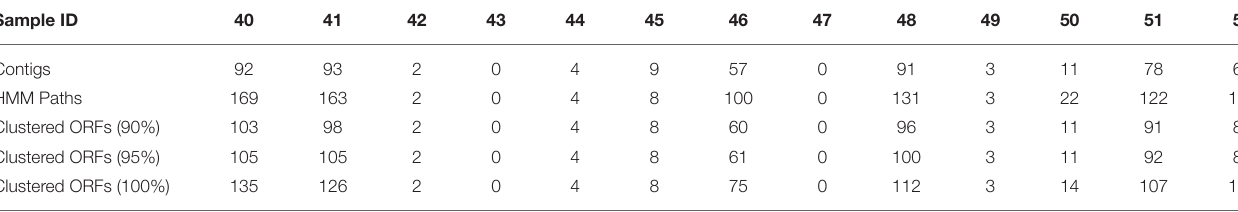
TABLE 1 | Abricate predicted AMR gene sequence counts in the URBAN dataset.